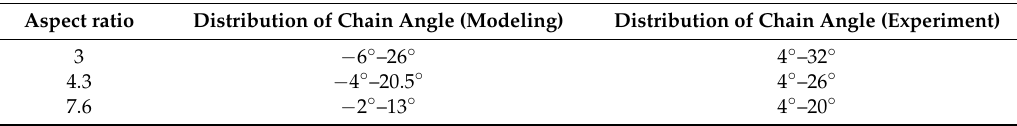
Table 5. Distribution of the chain angle from modeling and experimental